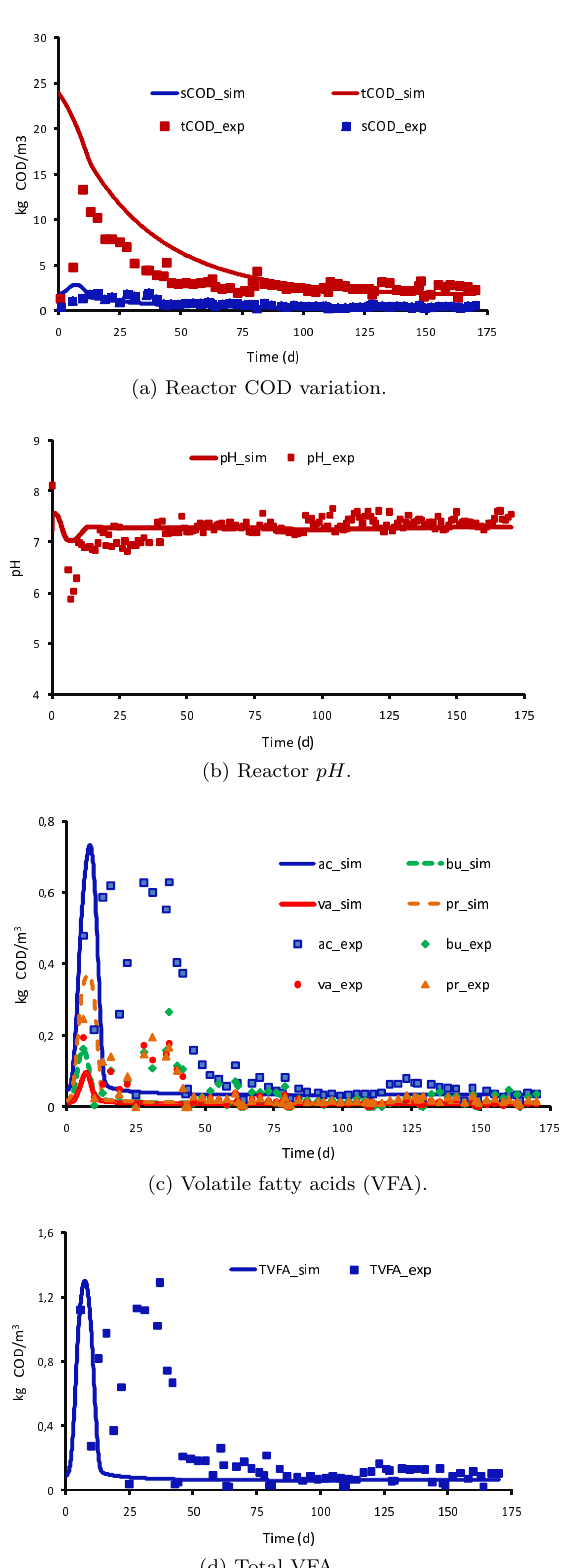
Figure 3: (a-d): Experimentally observed and simu- lated parameter variations for the semi con- tinuous feed anaerobic digester.